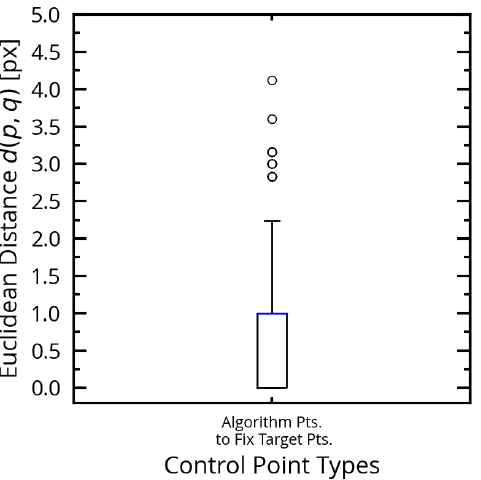
Figure 7. Euclidean distance between algorithm found control points and the fix grid control points for the dataset of 54,835 control points. The whisker lengths indicate 0% percentile to 99% percentile. As can be seen in the box plot in Figure 7, 75% of the Euclidean distances are below 1 px difference. In 99% (whisker length) of the cases, the Euclidean distances are below 2.24 px difference, which is less than ± 2 px difference between ideal point position and perspective corrected position of the algorithm detected CGJ point in the distortion corrected image. For the evaluation with the ground truth CGJ points the CGJ points in 40 random selected EL images were labeled, which provides 2200 ground truth control points